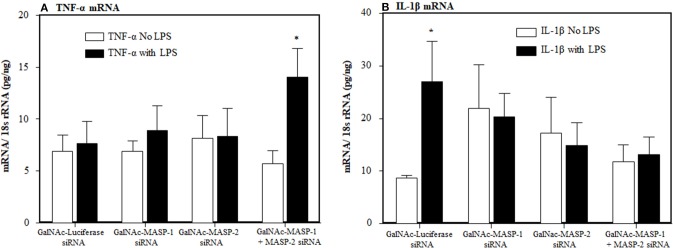
Effect of LPS on inflammatory cytokines after a long term silencing of MASPs. The expression of IL-1β and TNF-α cytokines, in liver, were measured by qRT-PCR. WT mice were injected three times with a single dose of GalNAc-Luciferase-siRNA, GalNAc-MASP-1-siRNA, GalNAc-MASP-2-siRNA and GalNAc-MASP-1+MASP-2-siRNAs followed by an injection of LPS or no LPS injection. Total mice used in this study were 34 i.e., GalNAc-Luciferase-siRNA followed by LPS (n = 4) or no LPS (n = 4), GalNAc-MASP-1-siRNA followed by LPS (n = 4) or no LPS (n = 4), GalNAc-MASP-2-siRNA LPS (n = 4) or no LPS (n = 5) and GalNAc-MASP-1+MASP-2-siRNAs LPS (n = 4) or no LPS (n = 5). Data are expressed as Mean ± SEM. *p < 0.05 considered significant.